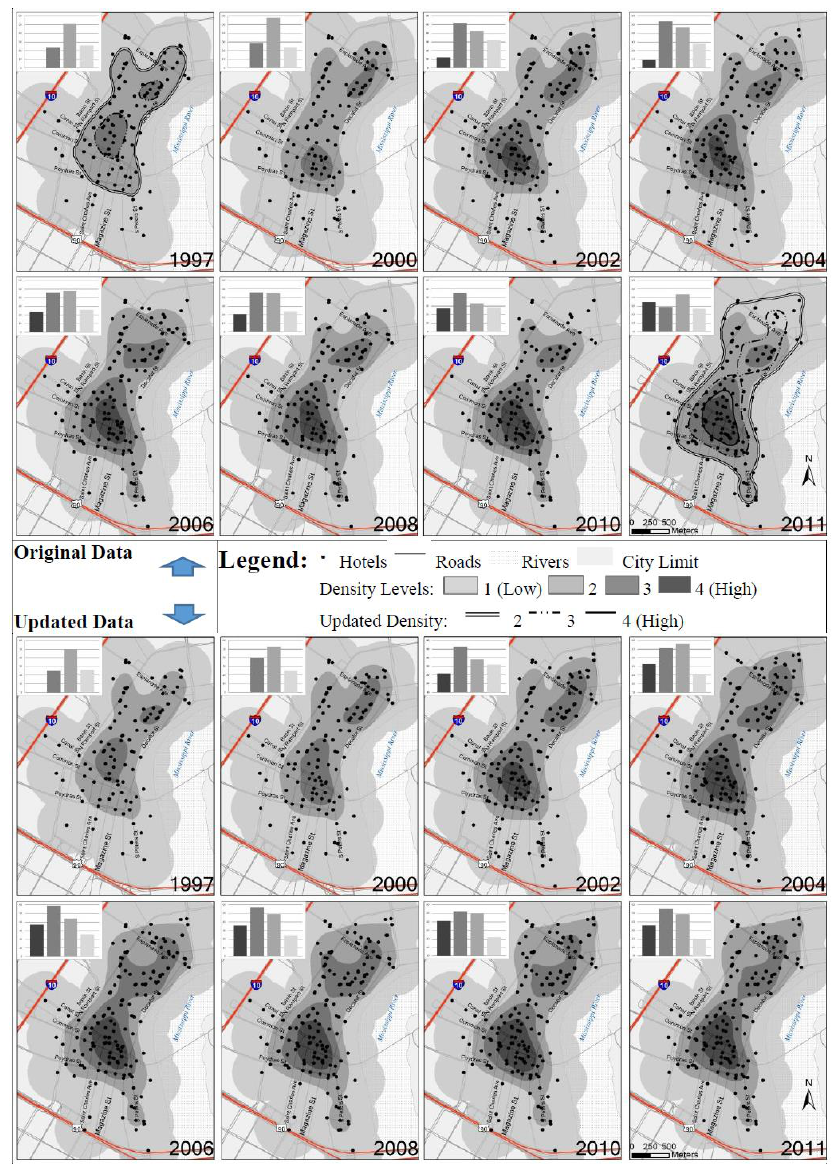
Figure 5. Kernel density of hotels: Original vs. updated (New Orleans, LA, USA).